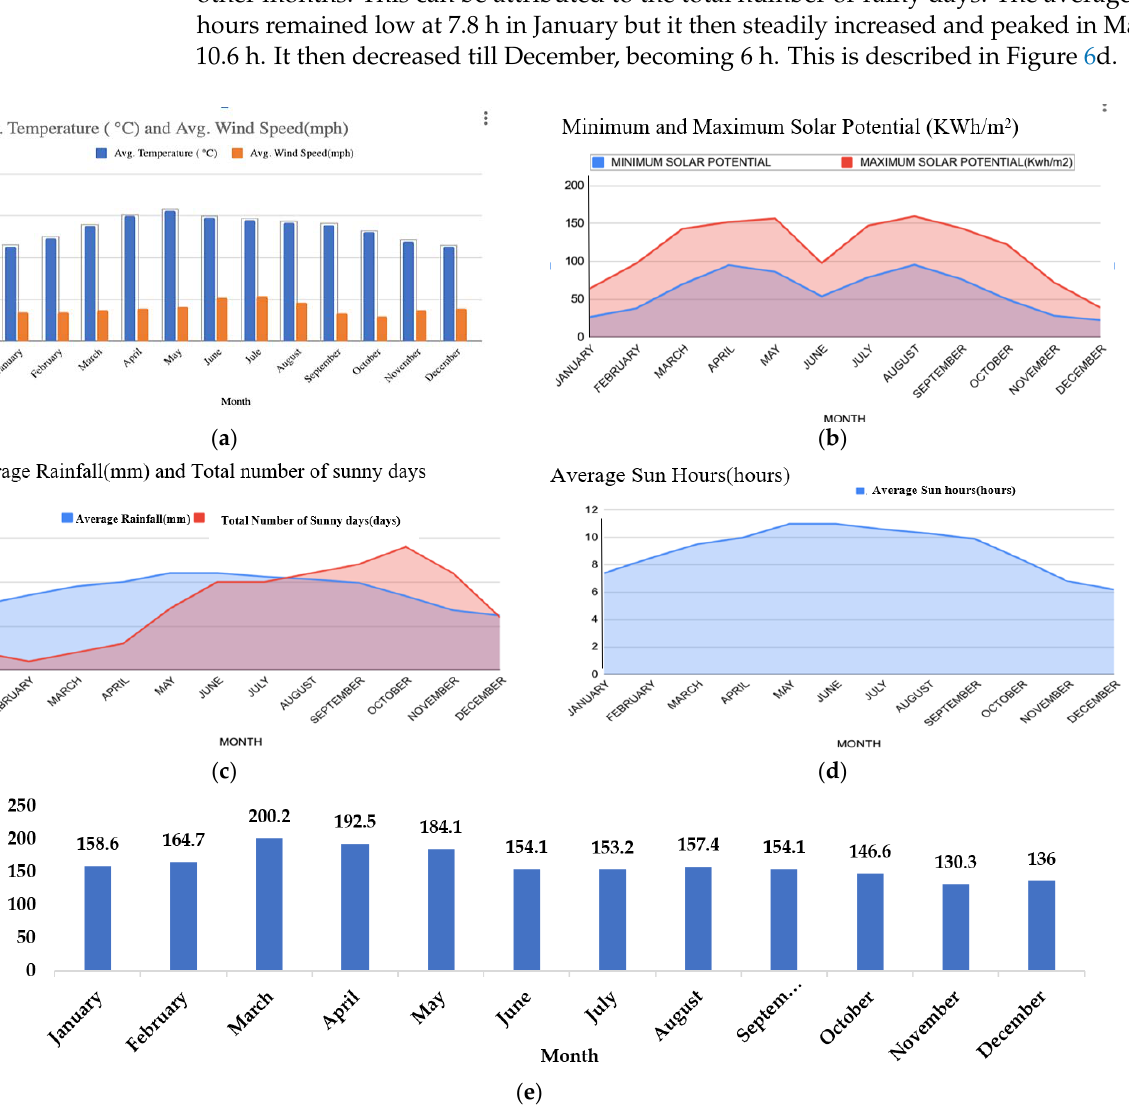
Figure 6. Monthly variation of various climatic parameters: ( a ) average temperature and wind speed; ( b ) minimum and maximum solar potential; ( c ) average rainfall and total number of sunny days; ( d ) average sun hours at Vellore; and ( e ) GHI irradiance per day by month.